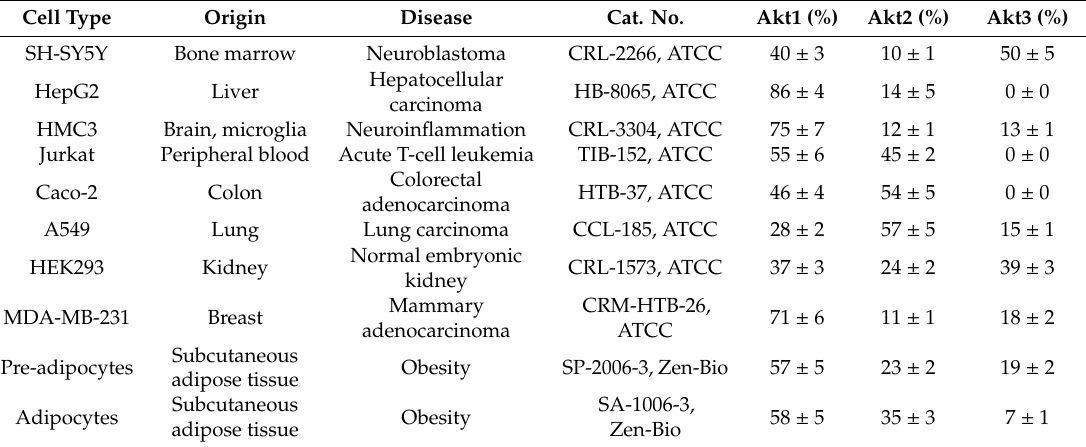
Table 1. Composition of Akt isoforms in cells of various